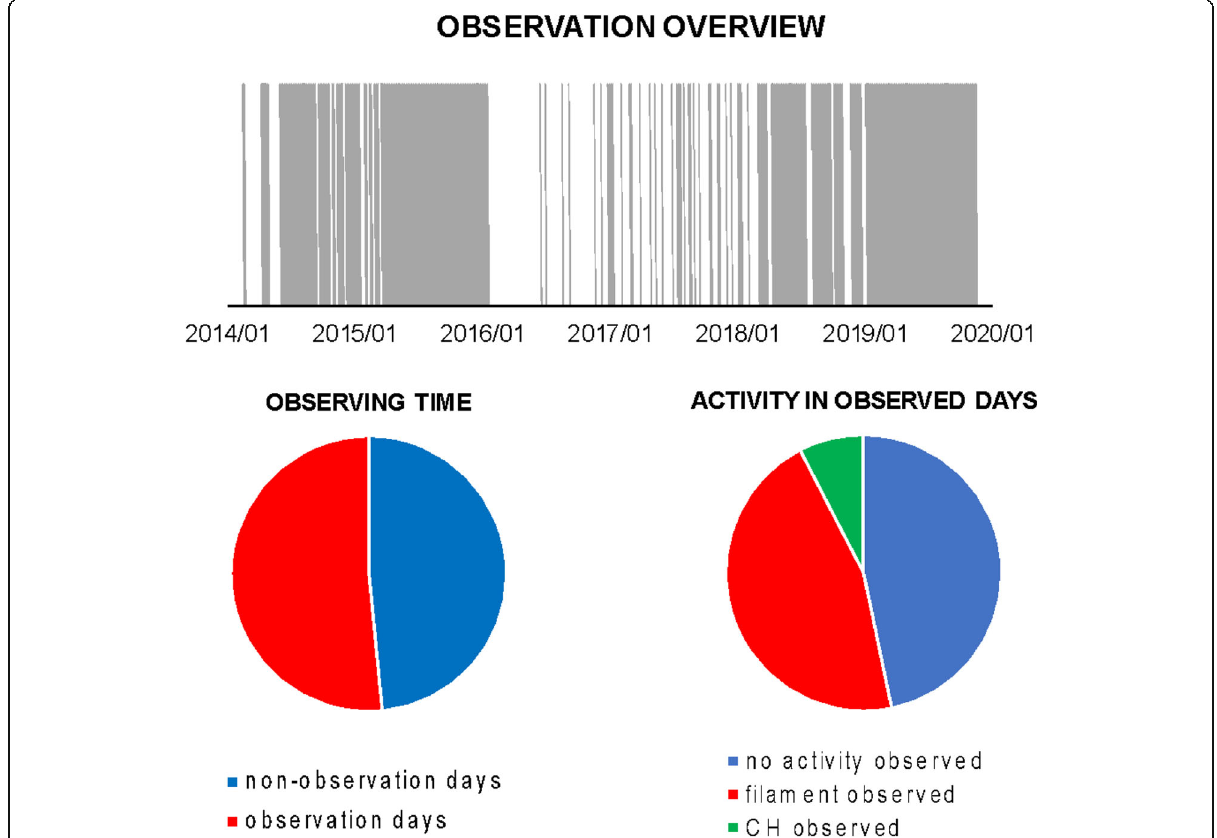
Fig. 40 On the top: archived non-flare target alerts 2014 – 2020; Bottom left: number of archived alerts (observation days) vs number of non- archived alerts (observation days); bottom right: number of quiet days, filament, and CH observations in the archived